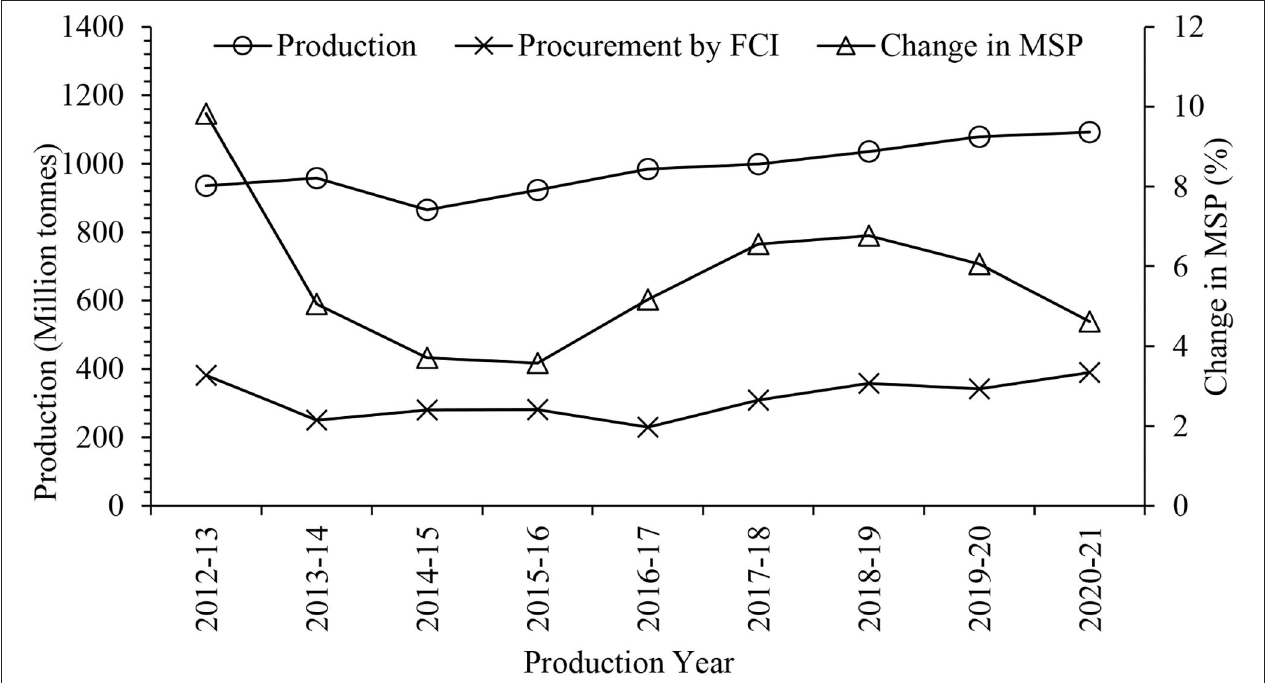
FIGURE 1 | Trend of production, procurement of wheat by FCI and MSP.